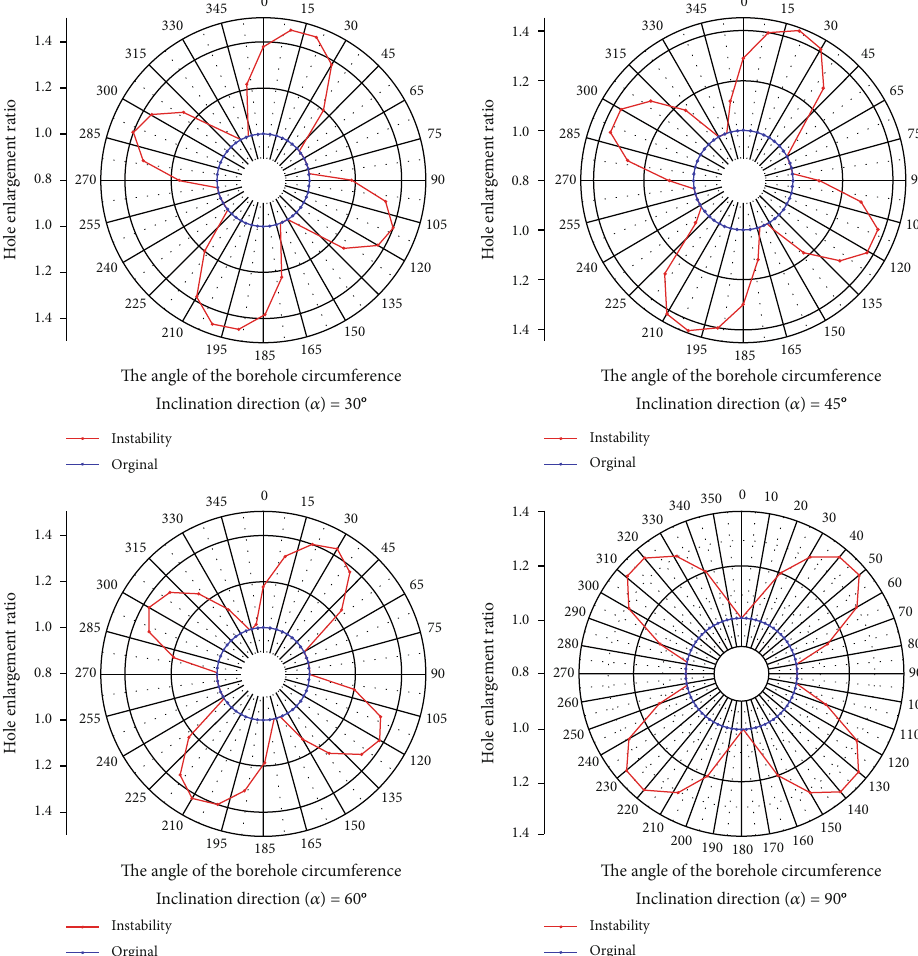
Figure 8: Characteristic shape of wellbore caving at 60 ° inclination angle of bedding